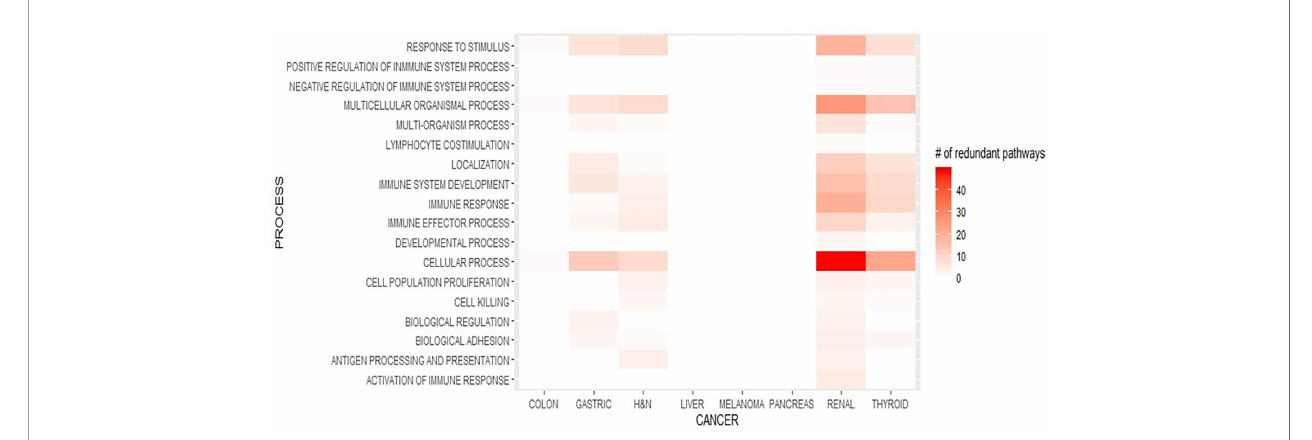
FIGURE 4 | Enriched immune processes in each cancer type in